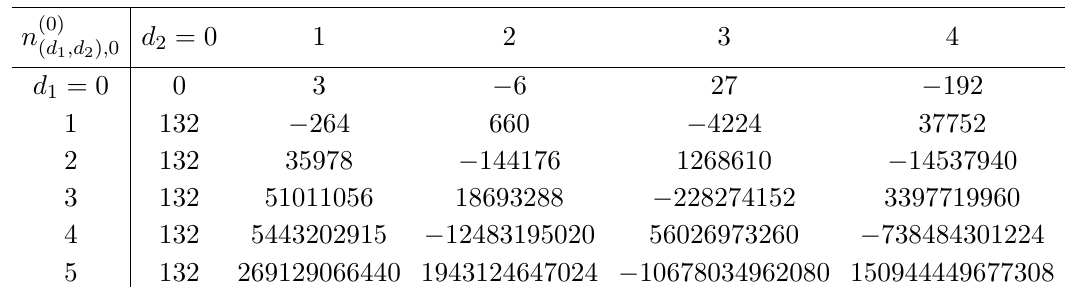
with Z charge 0 . 4 0